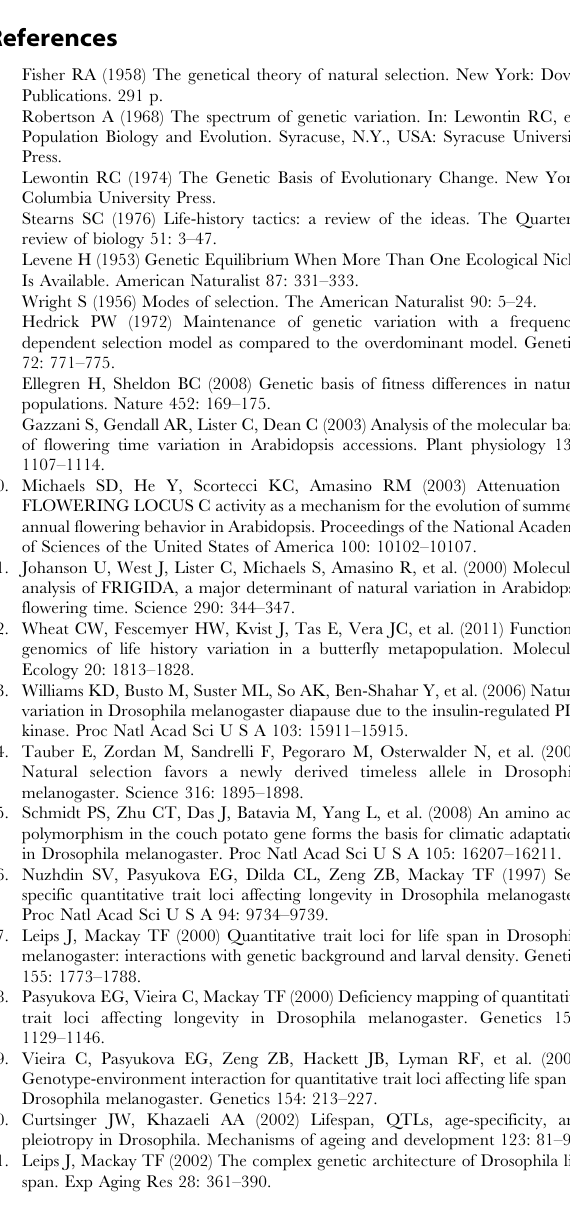
Table S1 Mixed effect model results for ovariole number. Table S2 Mixed effect model results for thorax length. Table S3 Mixed effect model results for development time. Table S4 Mixed effect model results for fecundity. Table S5 Phenotypic and genetic correlation matrices. Table S6 Quantitative complementation results.